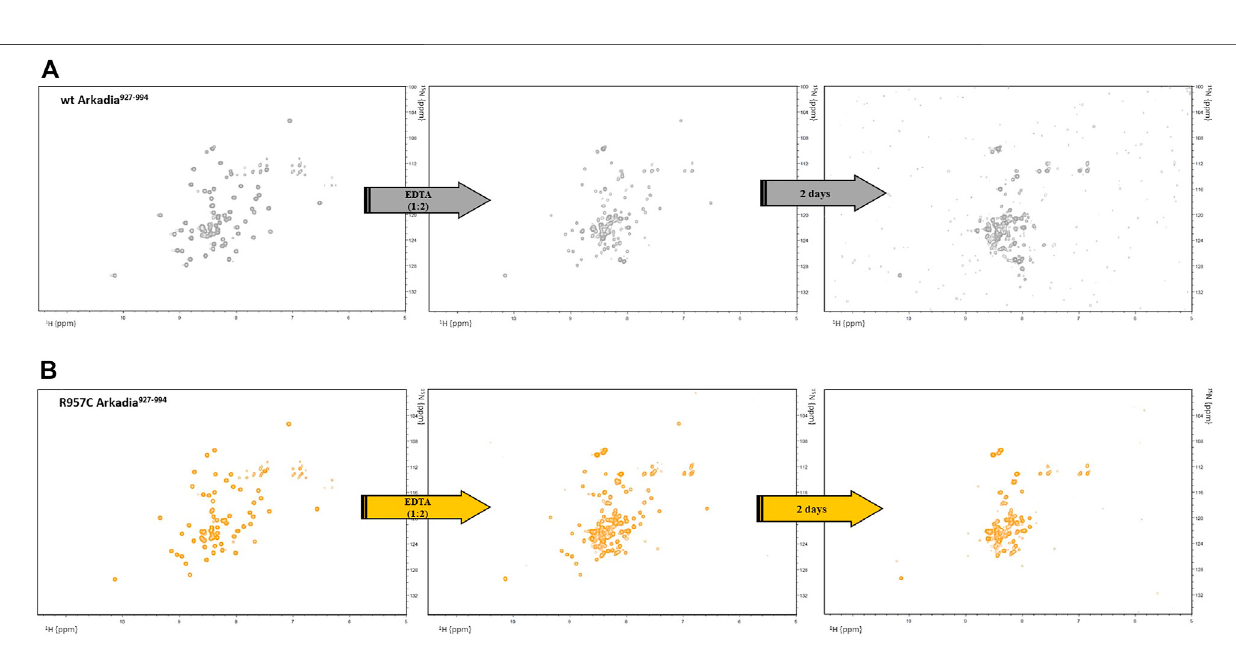
Frontiers in Molecular Biosciences |